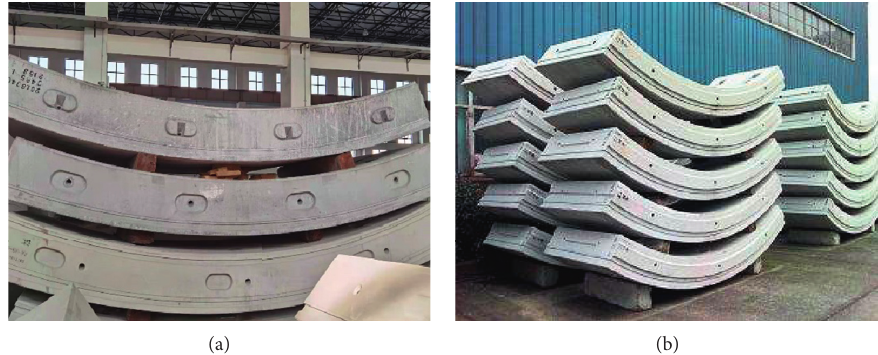
Figure 1: Circumferential joint. (a) Distributed mortises and tenons. (b) Full-ring mortises and tenons.